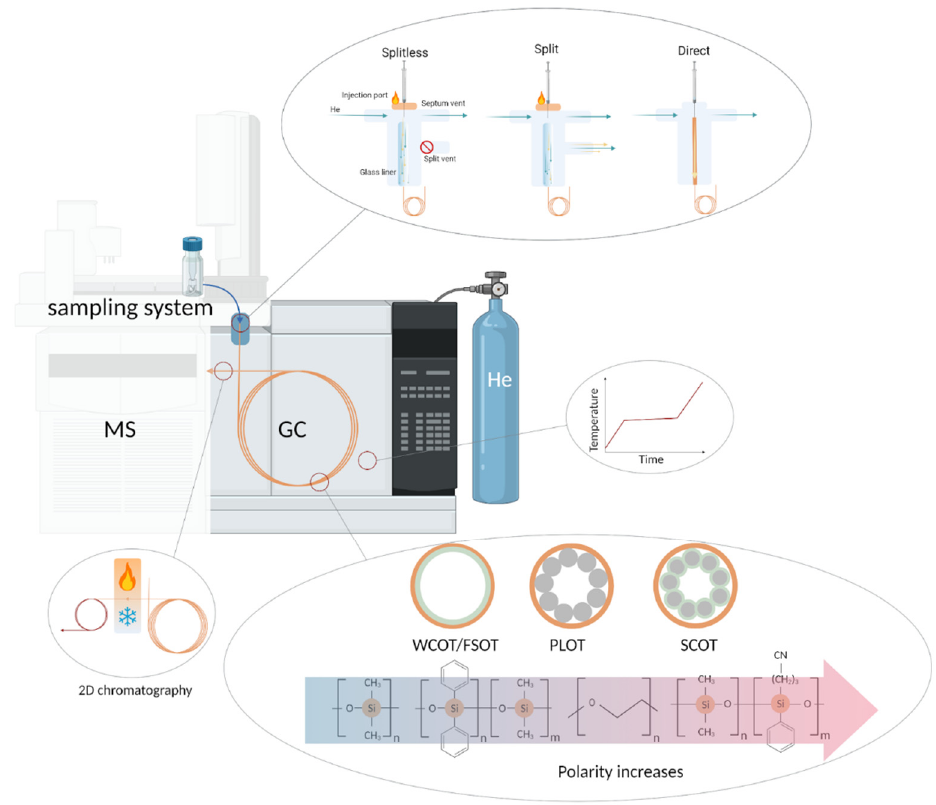
Figure 5. Schematic illustration of major units in the GC system. Abbreviations in the Figure: MS– mass spectrometry, GC–gas chromatography, 2D–two ‐ dimensional chromatography, WCOT ‐ wall ‐ coated open tubular column, PLOT ‐ porous ‐ layer open tubular column, SCOT ‐ support ‐ coated open tubular column, FSOT ‐ and fused silica open tubular column.